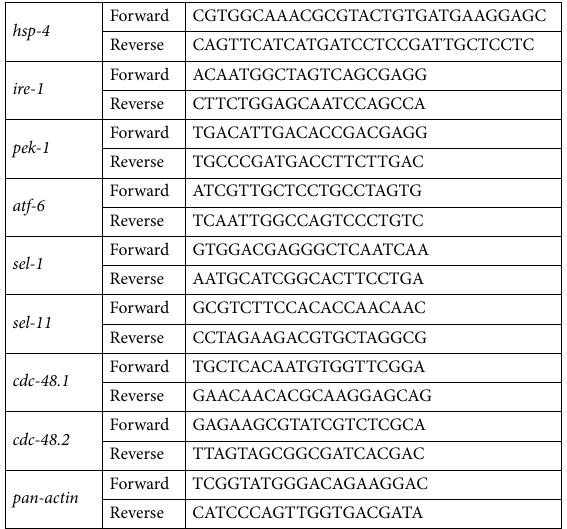
Table 1. Forward and reverse primer sequences for real-time